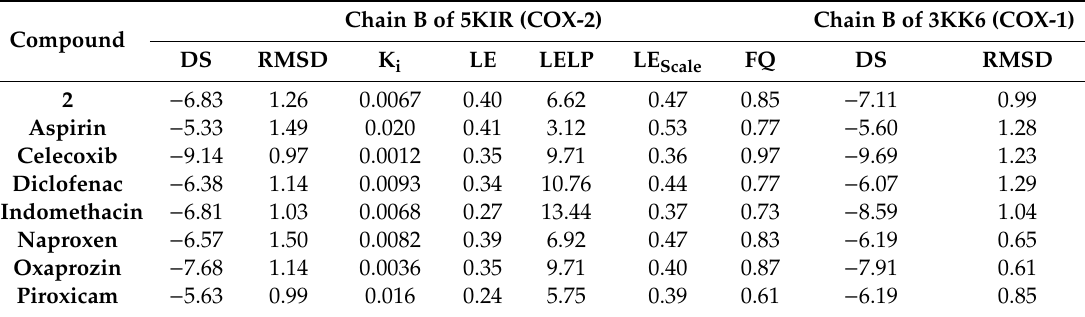
Table 1. Bioactivity parameters of compound 2 and selected NSAIDs.